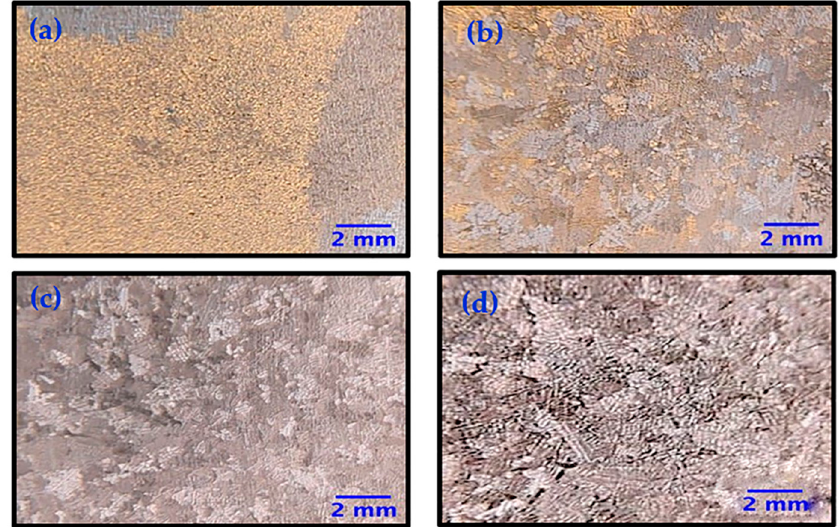
Figure 6. Optical microscopy images of the Co-Cr-Mo alloy samples, showing the grain size: ( a ) AM1 (coarse grains, no electromagnetic field application), ( b ) AM2 (fine grains), ( c ) AM3 (fine grains), and ( d ) AM4 (fine grains).